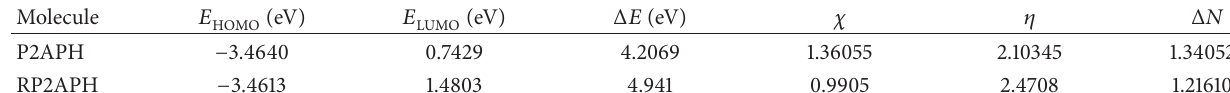
Table 3: Quantum chemical parameters of P2APH and RP2APH.